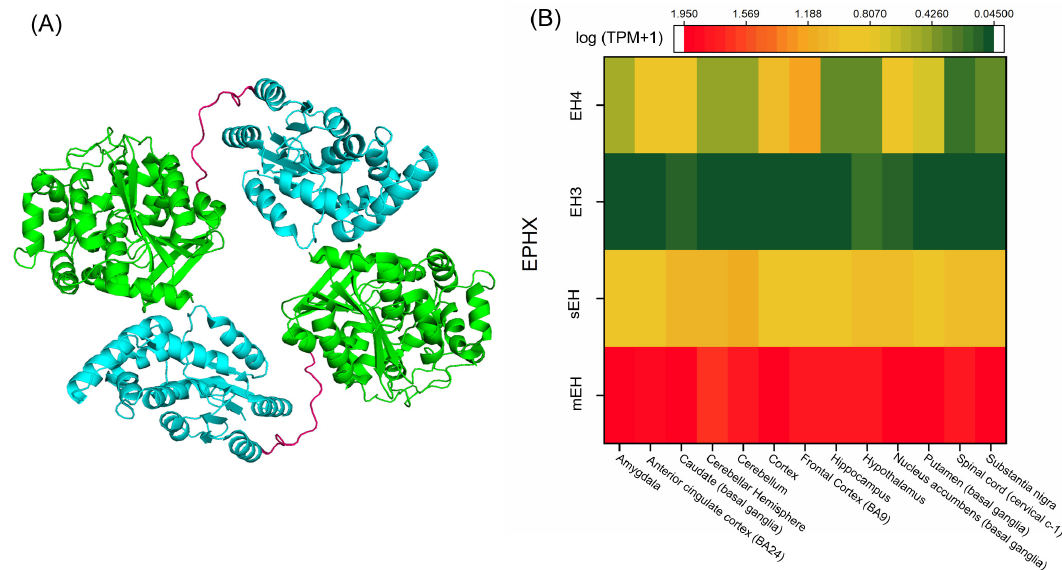
Figure 5. ( A ) Crystal structure of the sEH dimer (PDB accession code 1S8O) [150]. The sEH monomer is composed of two globular regions representing the α / β tertiary structure, and a short proline-rich linker (pink) connects the C-terminal of one monomer to the N-terminal region of another. The catalytic site with epoxide hydrolase activity is located within the C-terminal region, whereas the N-terminal region possesses phosphatase activity. ( B ) EH distribution in the human brain based on mRNA expression. Expression values are shown as a median of TPM, calculated from a gene model with isoforms collapsed to a single gene with no other normalization [152]. Abbreviations- EH: epoxide hydrolase, EH3: